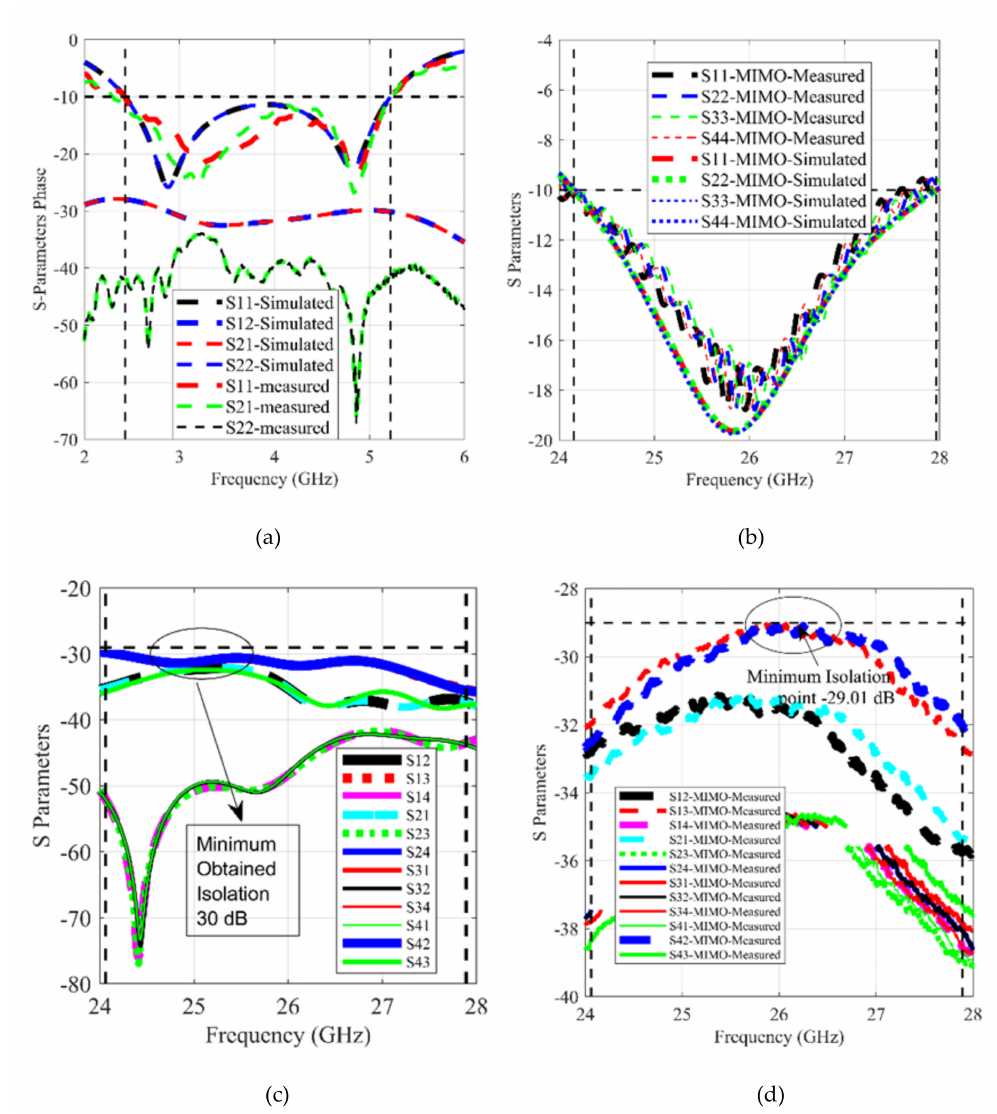
Figure 12. Scattering parameters for the mid-band (4G LTE and lower 5G) and high-band (5G mmWave) MIMO antennas integrated design: ( a ) measured and simulated scattering parameters for the mid-band (4G LTE and lower 5G) MIMO configuration; ( b ) measured and simulated reflection parameters for the high-band (5G mmWave) MIMO configuration; ( c ) simulated transmission param- eters for the high-band (5G mmWave) MIMO configuration; ( d ) measured transmission parameters for the high-band (5G mmWave) MIMO